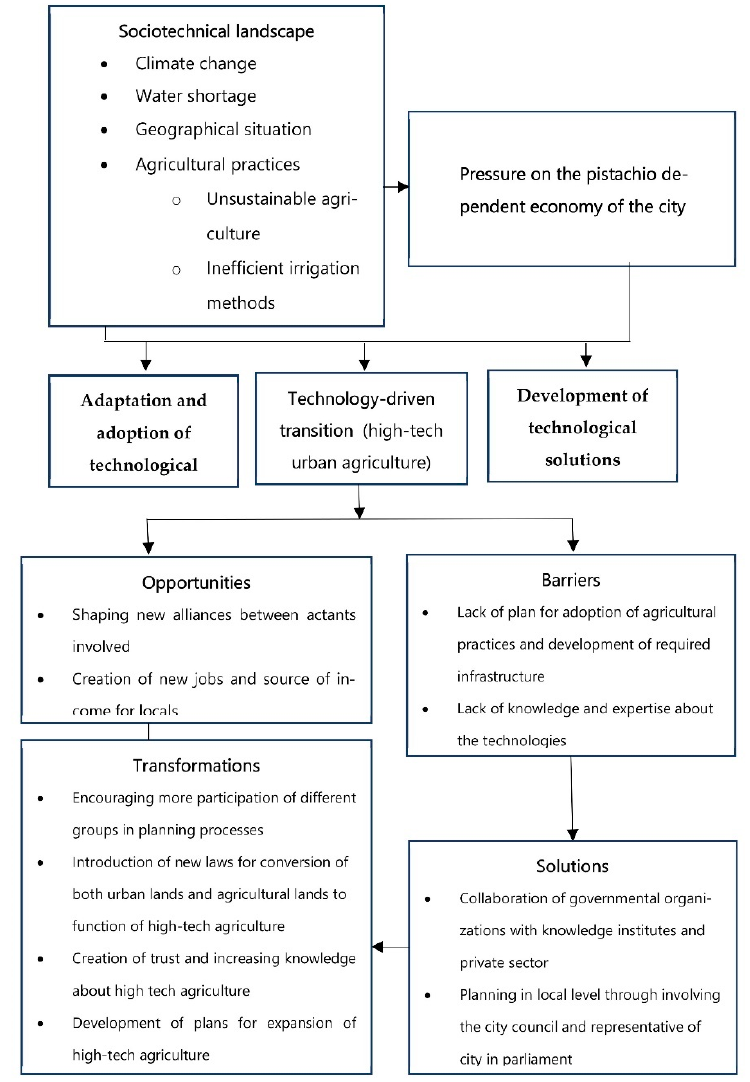
Figure 11. Transition process in the agricultural sector of Rafsanjan.